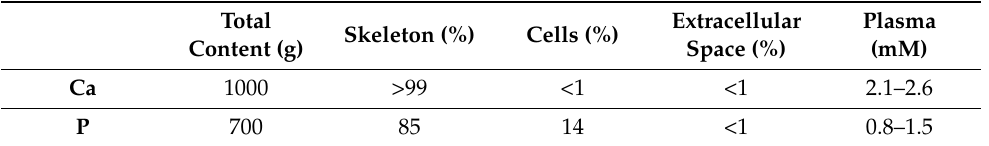
Table 1. Approximate amount and distribution of calcium and phosphorous in adult humans. Adapted from